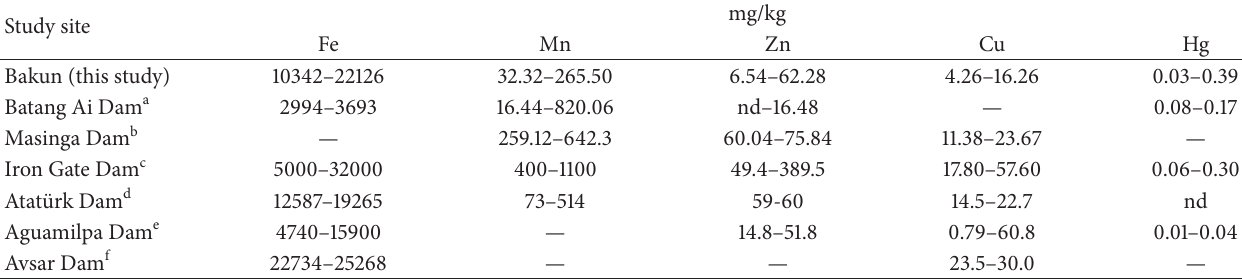
Table 3: The metals content in sediment reported in various studies with regard to the dam environment. Study